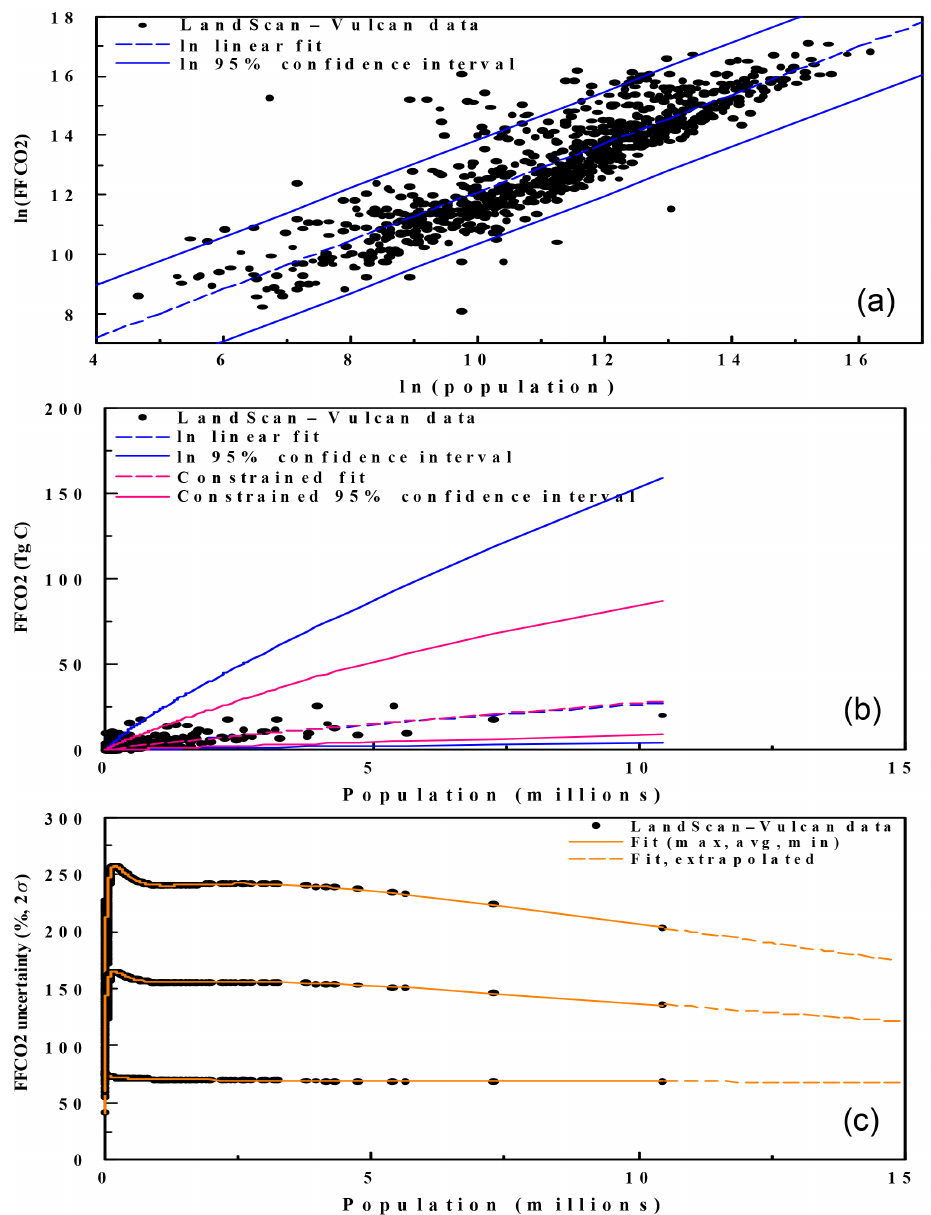
Figure 8. The population–FFCO2 emissions relationship. Upper panel: independent data sets of population and FFCO2 emissions are ag- gregated to 1 ◦ resolution and spatially matched. Dropped from the figure are three data points that had positive FFCO2 emissions and zero population and 67 data points where positive FFCO2 occurred in cells subject to population from an adjacent country. These cells may in- clude adjacent country population but not the FFCO2 emissions attributable to that population, thus degrading the desired population–FFCO2 emissions relationship. In addition to the 849 data points, a linear fit and 95% confidence interval are shown. Middle panel: same data as seen above except on linear axes. Monte Carlo analyses provided a constrained linear fit and 95% confidence interval with the constraint that the total mass of the system is constant and using a robust estimate of the data distribution. Lower panel: population–FFCO2 emissions 2 σ relationships extracted from the Monte Carlo analyses. Extraction is dashed where